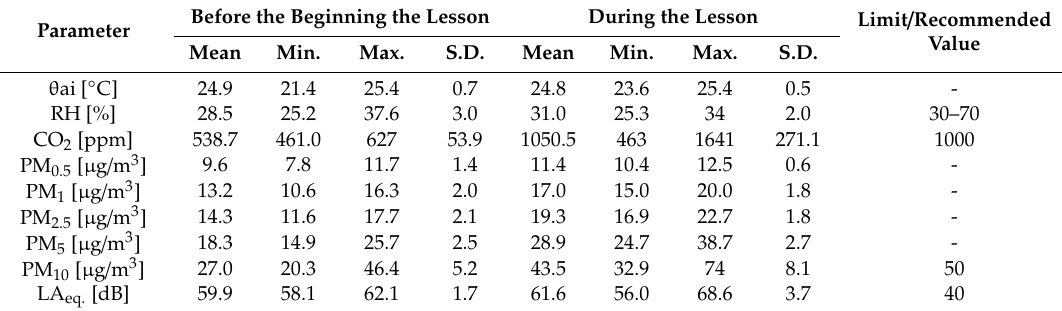
Table 3. Measured Indoor Environmental Parameters.